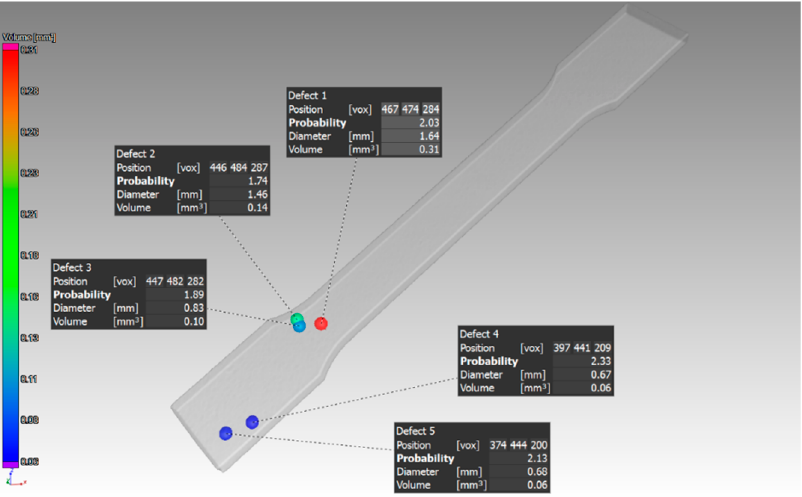
Figure 11. Specific defects on a sample with 2 mm thickness, which was oriented in the Z direction.